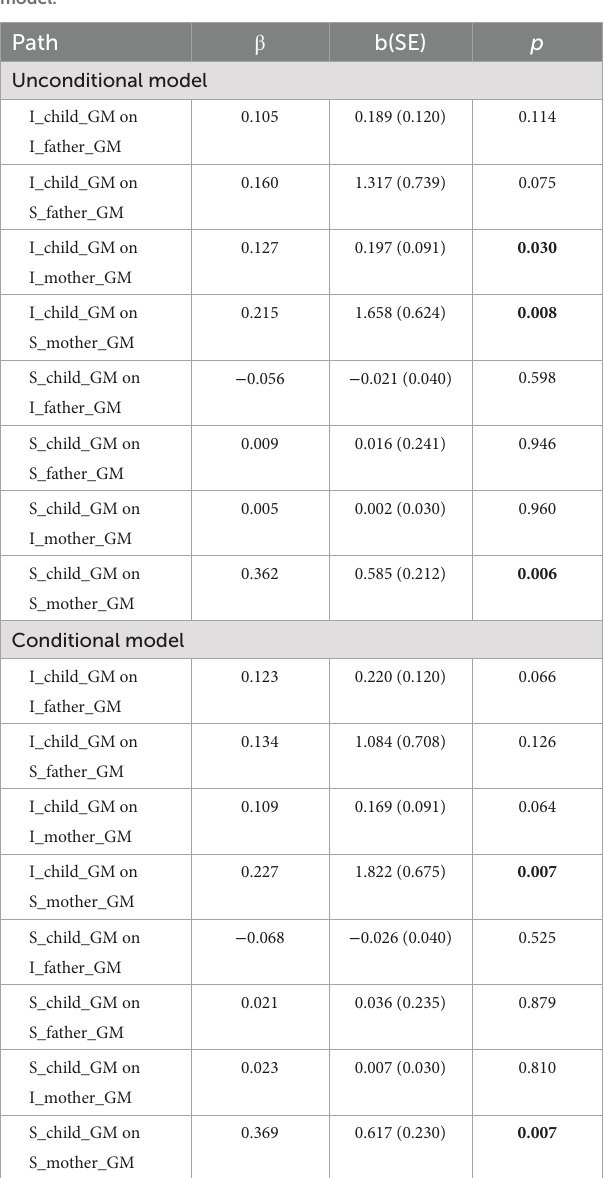
TABLE 4 Parameter estimates for parallel process latent growth curve